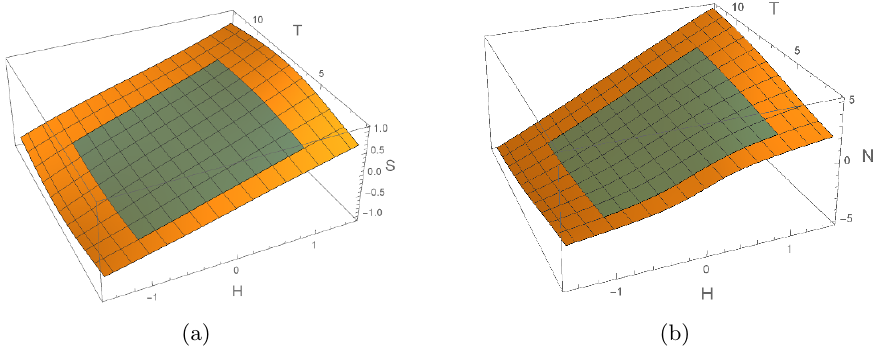
Figure 22 . The temperature and the magnetic (cid:12)eld dependence of (a) Seebeck coe(cid:14)cient, (b) Nernst